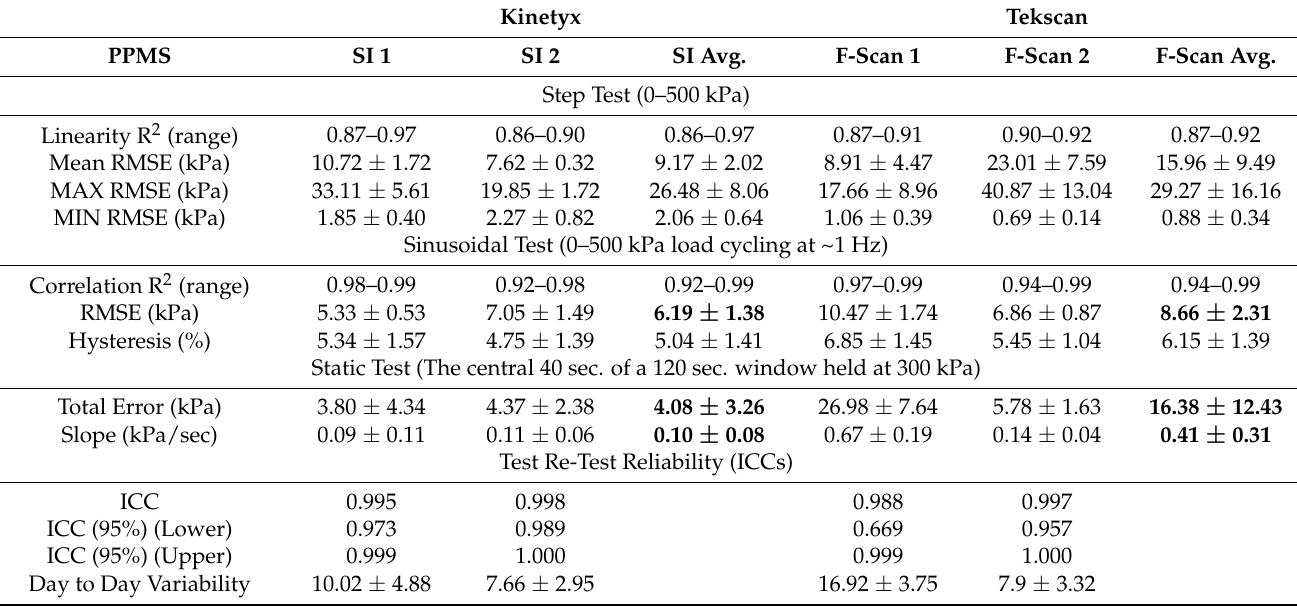
Table 2. Results from the benchtop testing of the Kinetyx SI and the Tekscan F-Scan system. Results are from tests evaluating both the absolute accuracy of the systems (Step Test, Sinusoidal Test) and for sensor response characteristics (Sinusoidal Test, Static Test) and for reliability (Test -ReTest Reliability). Significant differences between systems are shown in bold.